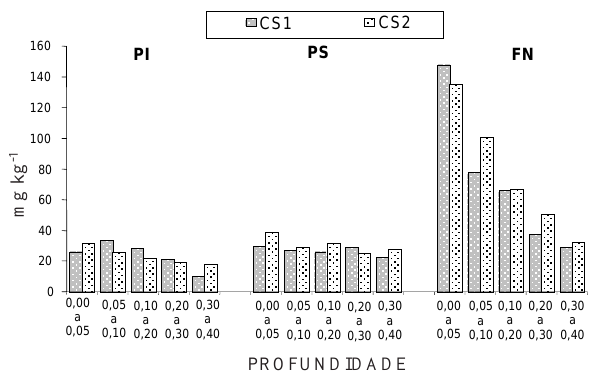
Figura 5. Carbono solúvel em água nos agregados maiores e menores que 0,25 mm, respectiva- mente (CS1 e CS2), de solos sob plantio direto irrigado (PI), plantio direto sequeiro (PS) e floresta nativa (FN), em cinco